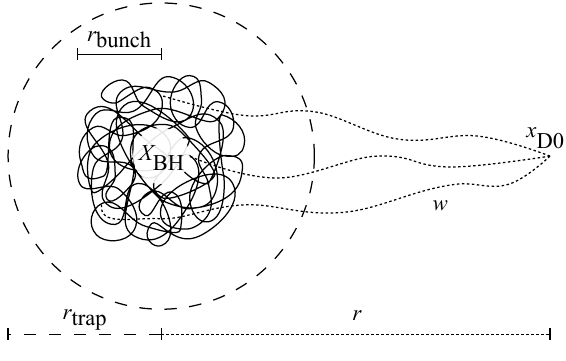
Figure 1 . A \black hole geometry" in a gauge theory. We also show the probe at x D0 and the open strings w that connect it to the black hole X BH , and the length scales r , r trap , and r bunch . (cid:12)nite temperature. Regardless of the relationship between r on the probe should cancel at T = 0 due to